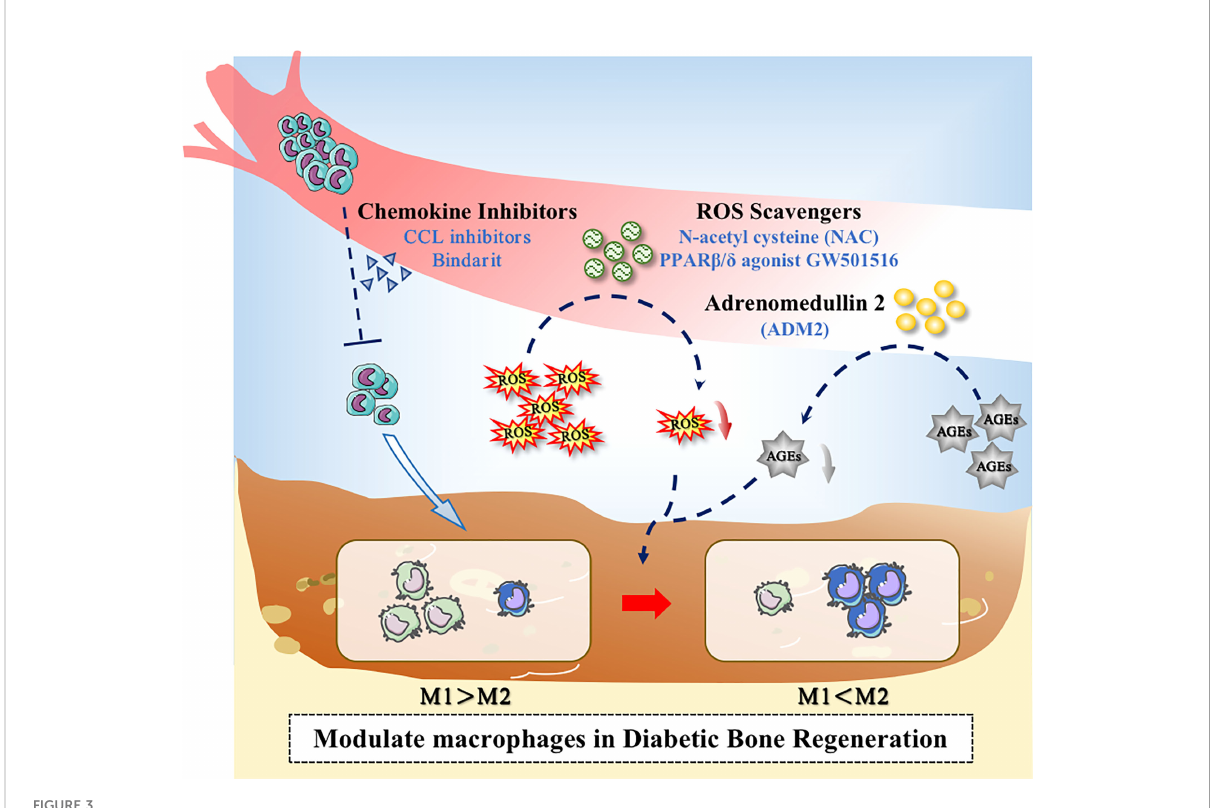
FIGURE 3 Application of drugs to modulate macrophages in the diabetic microenvironment. Drugs could promote bone regeneration in diabetes through the following ways: (1) Decreasing the excessive recruitment of monocytes; (2) Inhibiting the overproduction of ROS; (3) Inhibiting the level of